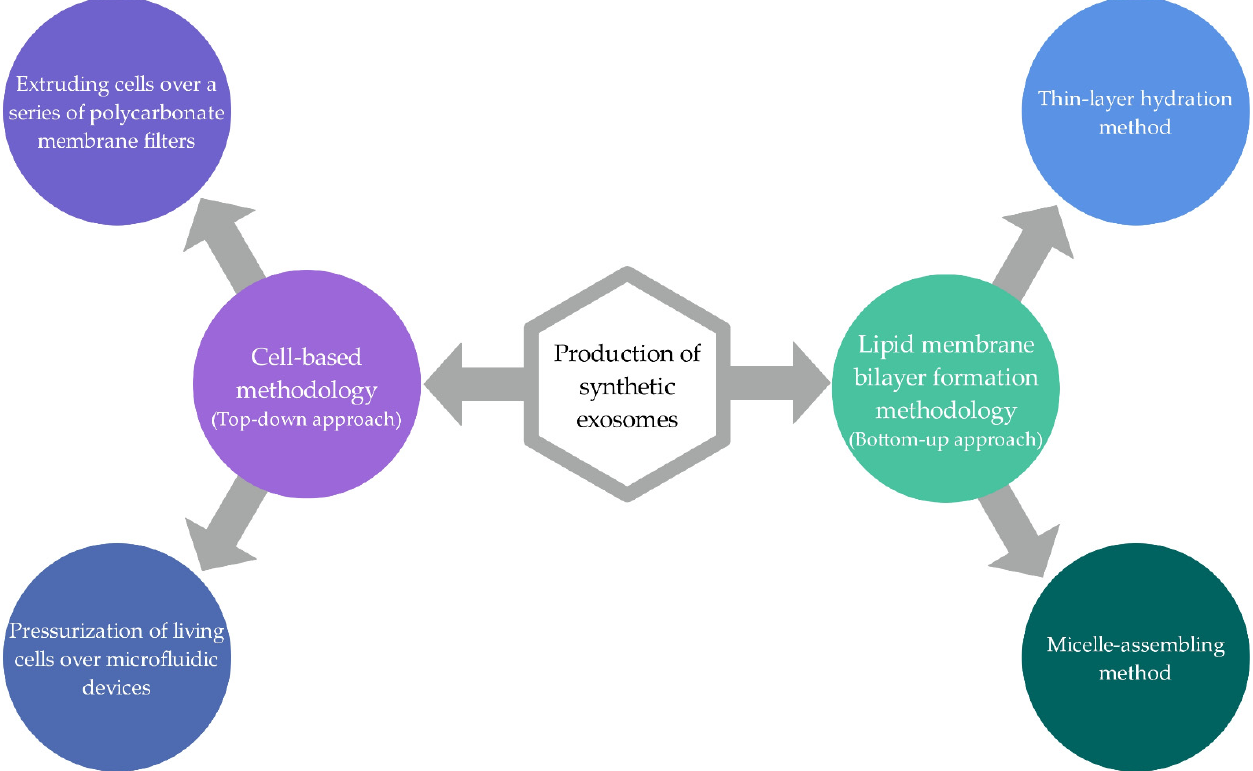
Figure 8. Schematic representation of methodologies for the production of synthetic exosomes—cell-based methodology and lipid membrane bilayer formation methodology (summarized from [9,20]).